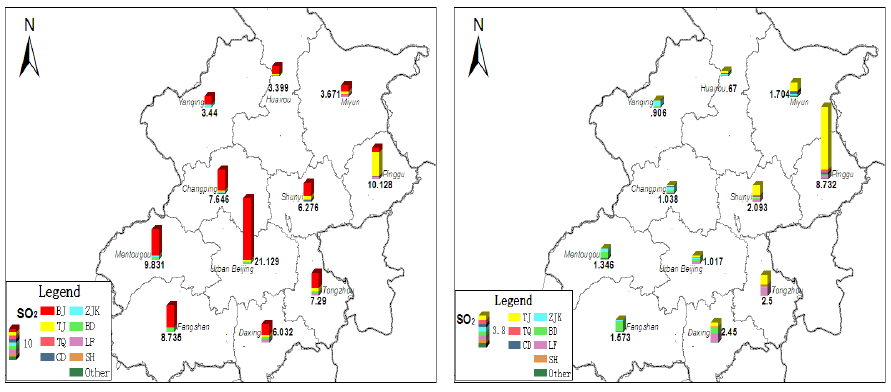
Fig. 7. The contribution to the SO 2 monthly mean concentration (ppbv) over Beijing counties at surface layer, including Beijing local contribution (left) and without Beijing contribution (right).